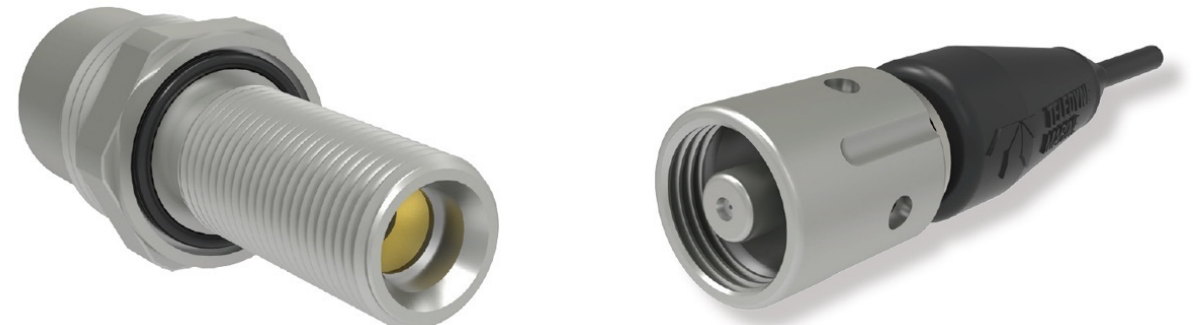
Figure 7. The Impulse-PDM Optical 12,000 Meter Connector [41].